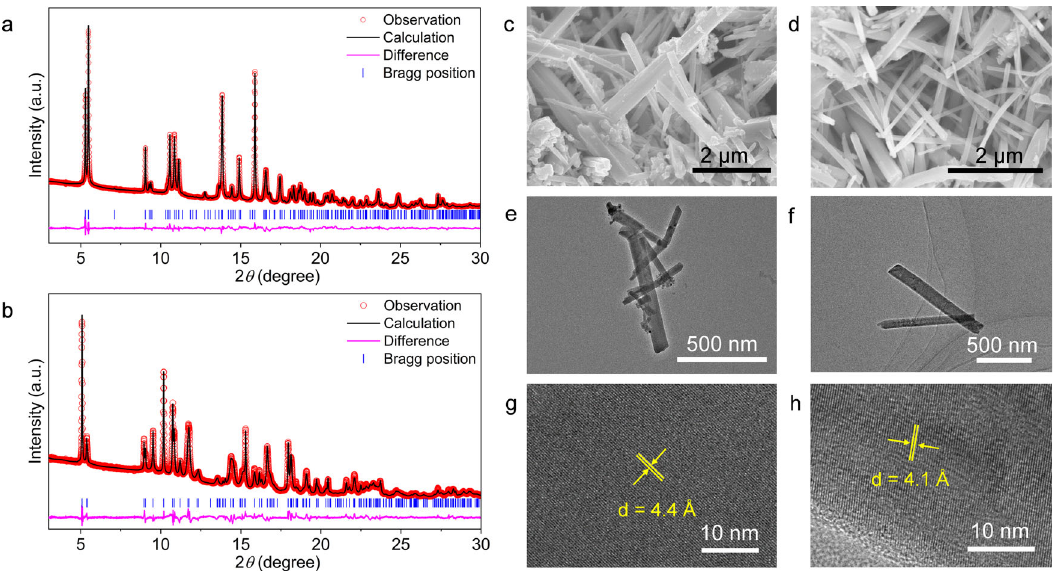
Fig. 2 | The structural and morphology characterization of CuAg x BHT. a , b Rietveld re fi nement of PXRD patterns for CuAg 4 BHT ( a ) and CuAg 2 BHT ( b ) from a synchrotron source ( λ =0.69003Å). c – f The SEM images of CuAg 4 BHT ( c )